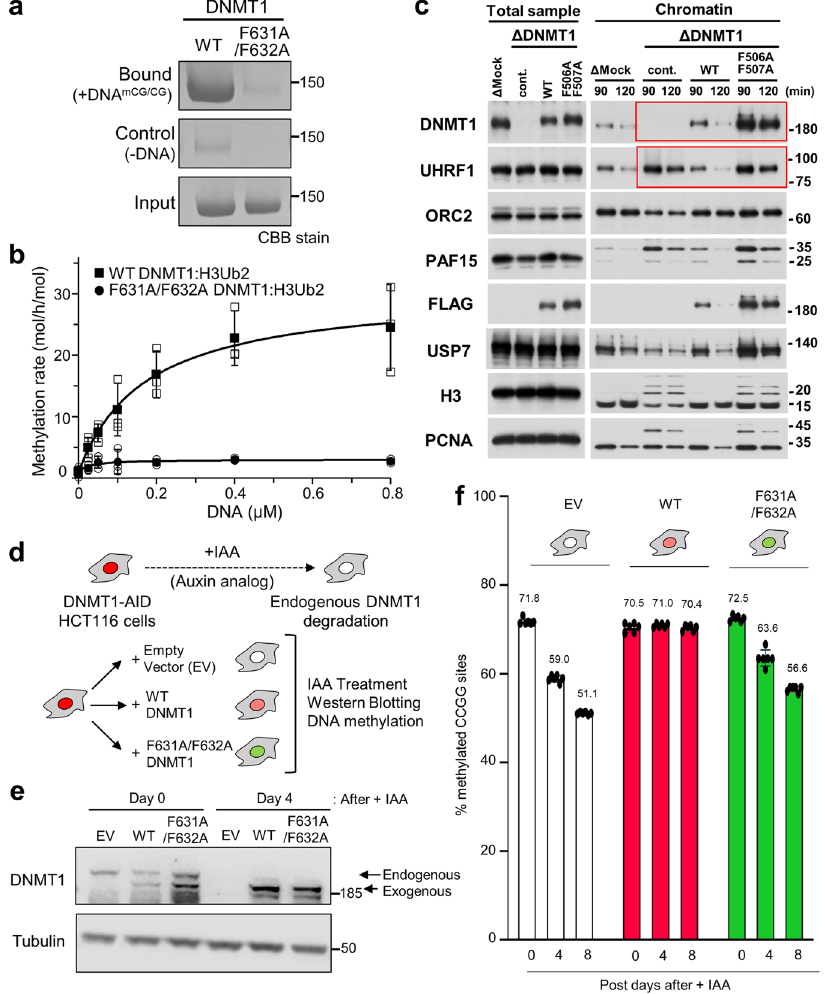
Fig. 4 | Functional assays demonstrate theimportance oftheActivating Helix. a Pull-down assay using immobilized hemimethylated DNA. Three independent experiments were performed. b in vitro DNA methylation activity of DNMT1 WT (blacksquare:meanvalue,whitesquare:threeindependentexperimentvalues)and F631A/F632A mutant (blacks circle: mean value, white circle: three independent experiment values) for hemimethylated DNA. The vertical axis indicates the turn- over frequency of the methylation reaction of DNMT1 (15nM) after 1h. Michaelis – Mentencurveisshownaslines.Datawerepresentedasmeanvalues±SD for n =3. c Interphase extracts depleted with either control or xDNMT1 antibodies wereincubatedwithcontrolbuffer,puri fi edrecombinantWTxDNMT1,andF506A/ F507A. The chromatin fractions were isolated at the indicated times and their boundproteins,aswellasinputs,wereanalyzedbyimmunoblotting.Thegelimage is representative of n =3 independent experiments. d Experimental scheme in